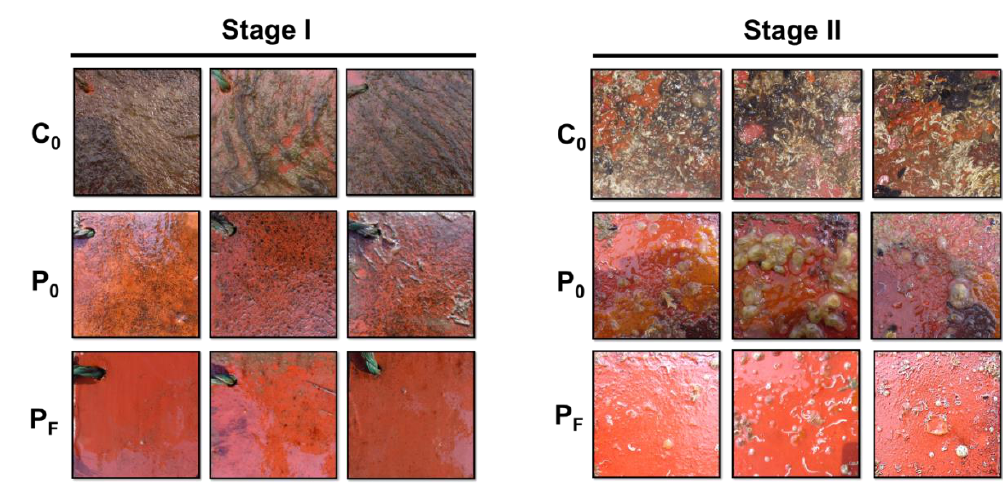
Figure 2. Images of the tested steel substrates coated with different coatings (i.e., C 0 , P 0 and P F surfaces) immersed in the natural seawater at different exposure times. Stage I: Oct.19, 2013-Mar.18, 2014, 150 days; Stage II: Mar.25, 2014-July.13, 2014,110 days.